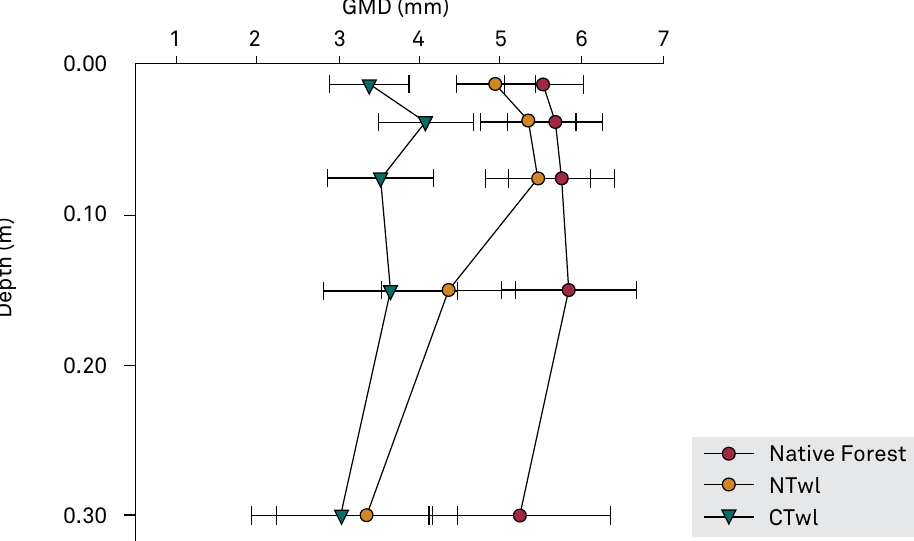
Figure 3. Geometric mean diameter (GMD) of the soil aggregates as affected by soil use and tillage systems in a Latossolo Bruno Alumínico típico (Hapludox). Horizontal bars indicate the interval of least significant difference for the t test and their overlap in the same soil layer means the absence of differences between the averages of the systems. CTwl: conventional tillage without lime; and NTwl: no-tillage without lime.